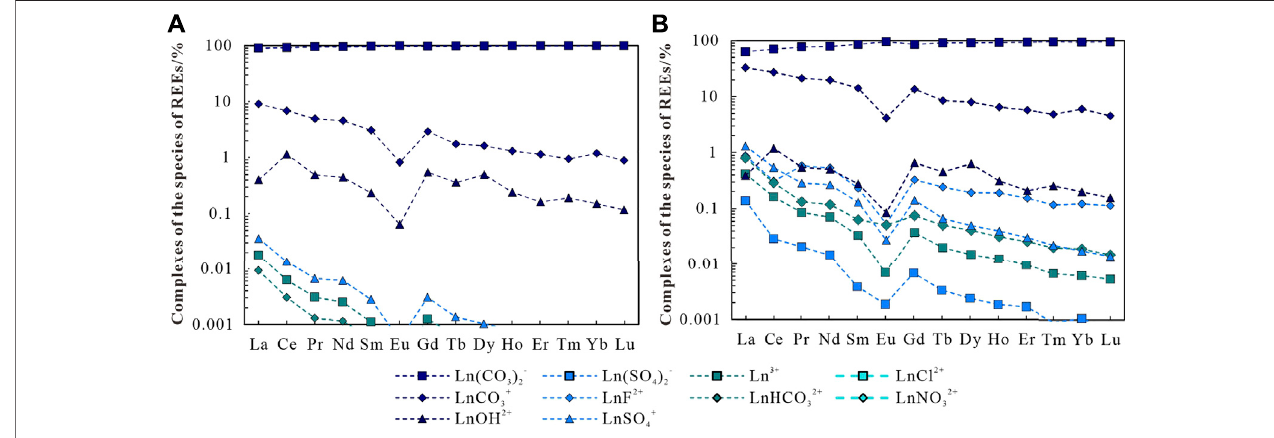
Frontiers in Earth Science |